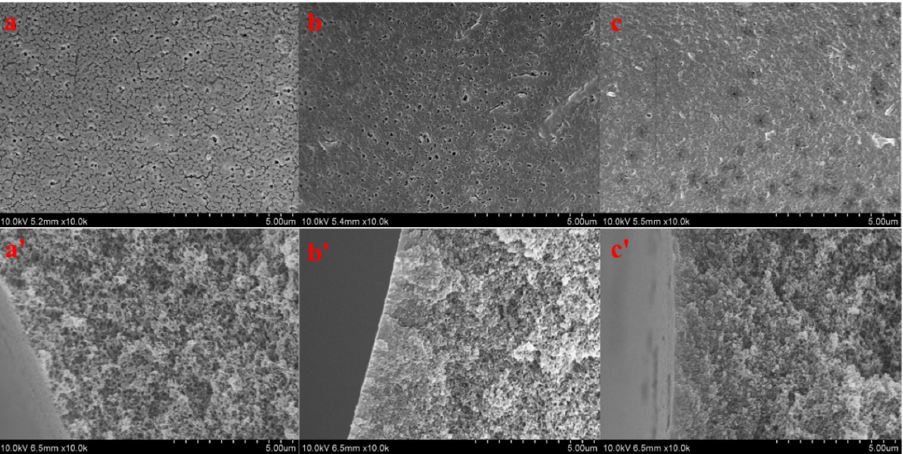
Figure 6. Surface and cross-sectional morphologies of PSF ( a , a (cid:48) ), PSF-PDA / PEI ( b , b (cid:48) ), and PSF-diol ( c , c (cid:48) )